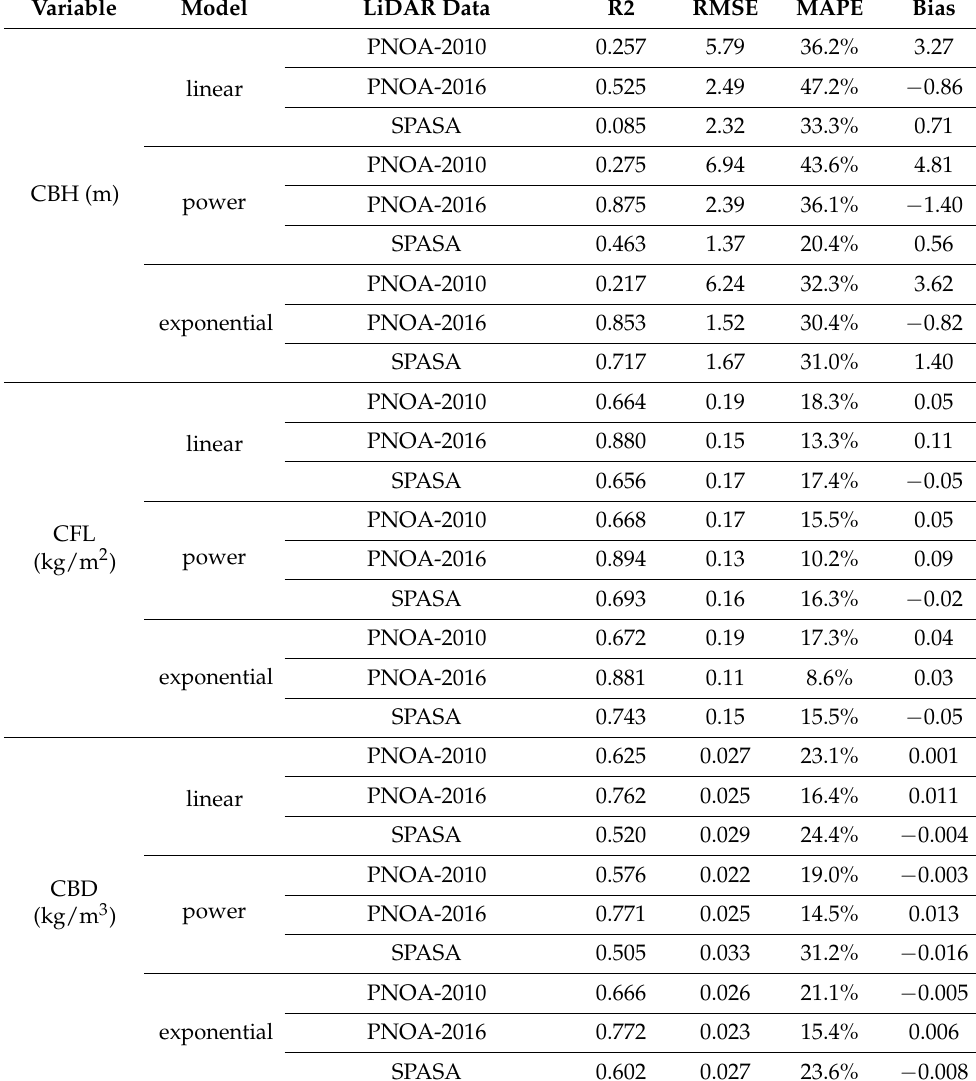
Table 6. Performance of the best canopy fuel models fitted with PNOA-2018 LiDAR for each formulation transferred to the different LiDAR data available in the study area. R 2 denotes agreement between observed and predicted values. CBH, canopy base height; CFL, canopy fuel load; CBD, canopy bulk density; RMSE, root mean square error; MAPE, mean absolute percentage error. Variable Model LiDAR Data